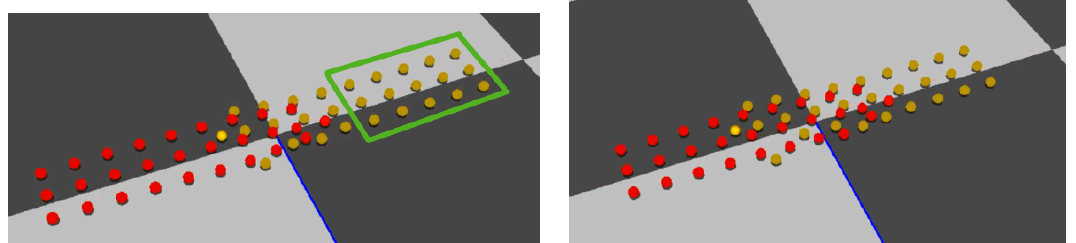
Figure 8. Our model containing two groups of agents confronting each other in opposite directions. Agents remain in their formation when there is no danger of colliding with other agents. In another word, while the agents in the first lines of the group are changing their position for collision avoidance behavior, other agents in the last lines keep the group’s formation independently (agents in the green